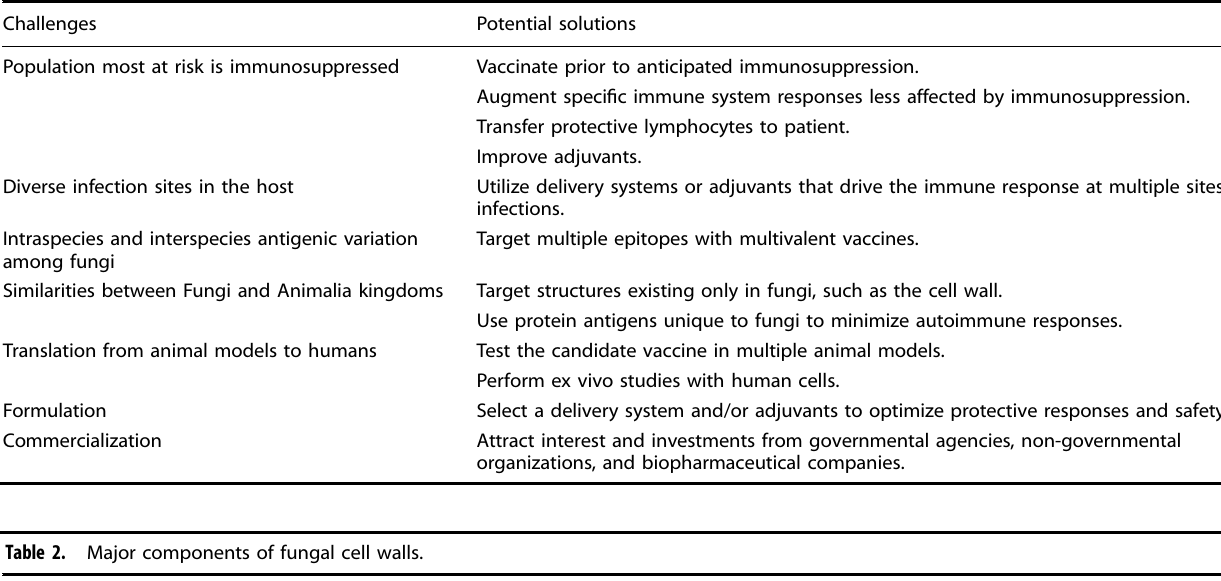
Table 1. Challenges associated with fungal vaccine development.